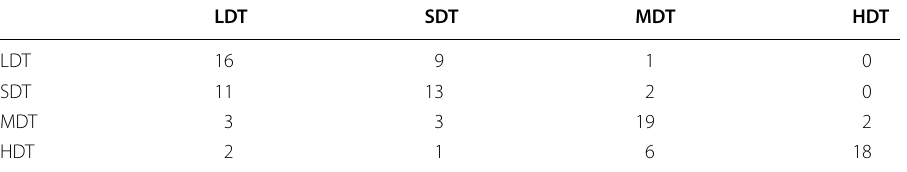
Table 9 Confusion matrix for the Ensemble Tree Predictor